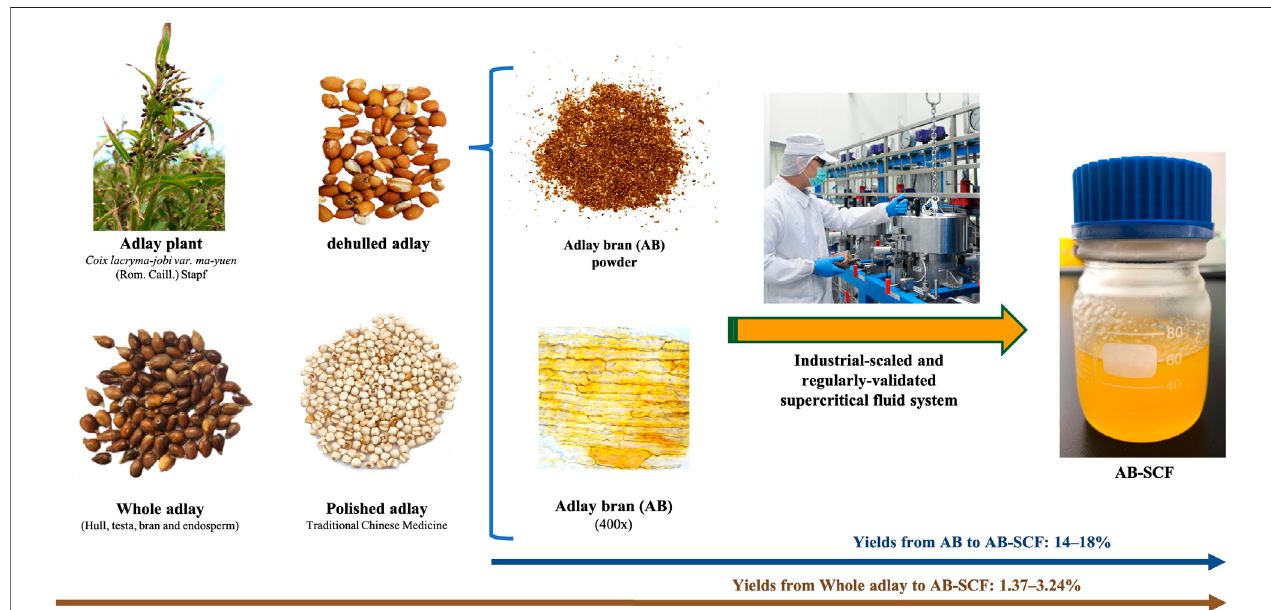
FIGURE 1 | Adlay, adlay bran and the AB-SCF manufacturing processes. The yields of AB-SCF from AB were averagely 14 – 18%. The recovery of AB-SCF from whole adlay seeds was 1.37 – 3.24%. AB-SCF was extracted by an industrial-scaled and regularly-validated supercritical fl uid system (NATEX Process Technology GmbH, Ternitz, Austria) settled in the Joben Bio-Medical Co., Ltd. (Pingtung,